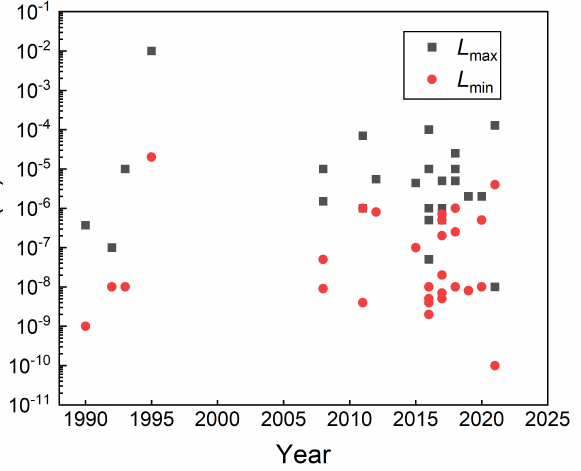
Figure 10. the max/min values of scales used in fractal literature of thin films in recent decades.